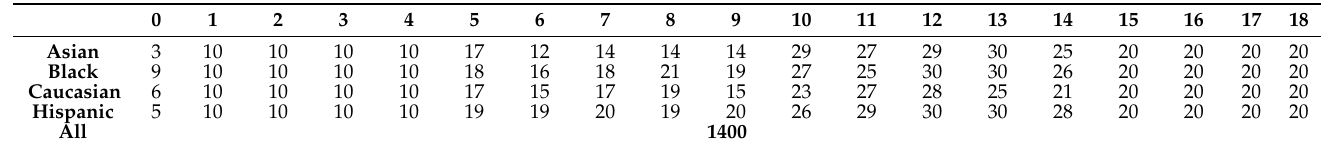
Table 2. Distribution of the images of the DHA dataset.